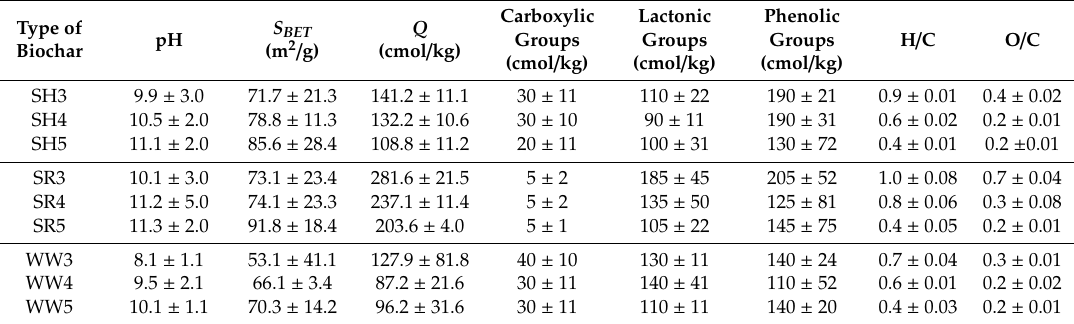
Table 1. Characteristics of agricultural biochars with standard deviations ( n = 3): SH3